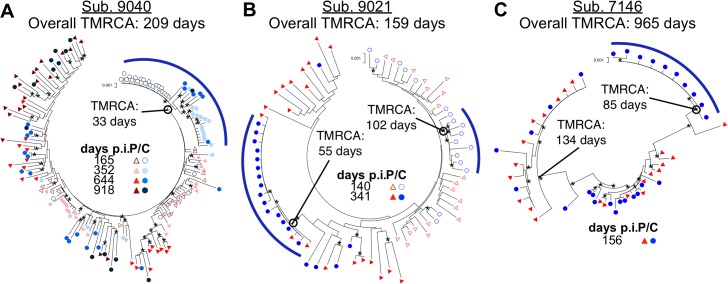
Compartmentalization can persist and evolve independently within the CSF over time.Neighbor-joining phylogenetic trees showing how compartmentalization can: (A) be persistent with multiple clonal expansions allowing recombination; (B) consist of sequential transient clonal expansions; and (C) be established with a transmitted variant. env sequences from the CSF are labeled with circles (C, colors designated in figure) and env sequences from the blood plasma are labeled with triangles (P, colors designated in figure). Days p.i. are noted. Bootstrap values ≥ 50 are indicated (*) at the appropriate nodes to highlight the more significant branch points. Genetic distance is indicated at the top of each phylogenetic tree (0.001, number of nucleotide substitutions per site between env sequences.) Compartmentalized populations are indicated at the appropriate node by an open circle and emphasized using a blue bar. BEAST-generated TMRCAs of the entire viral population are noted adjacent to the subject ID, and the TMRCAs of the different compartmentalized linages (subject 9040 and 9021) and transmitted parental lineages (subject 7146) are also noted.